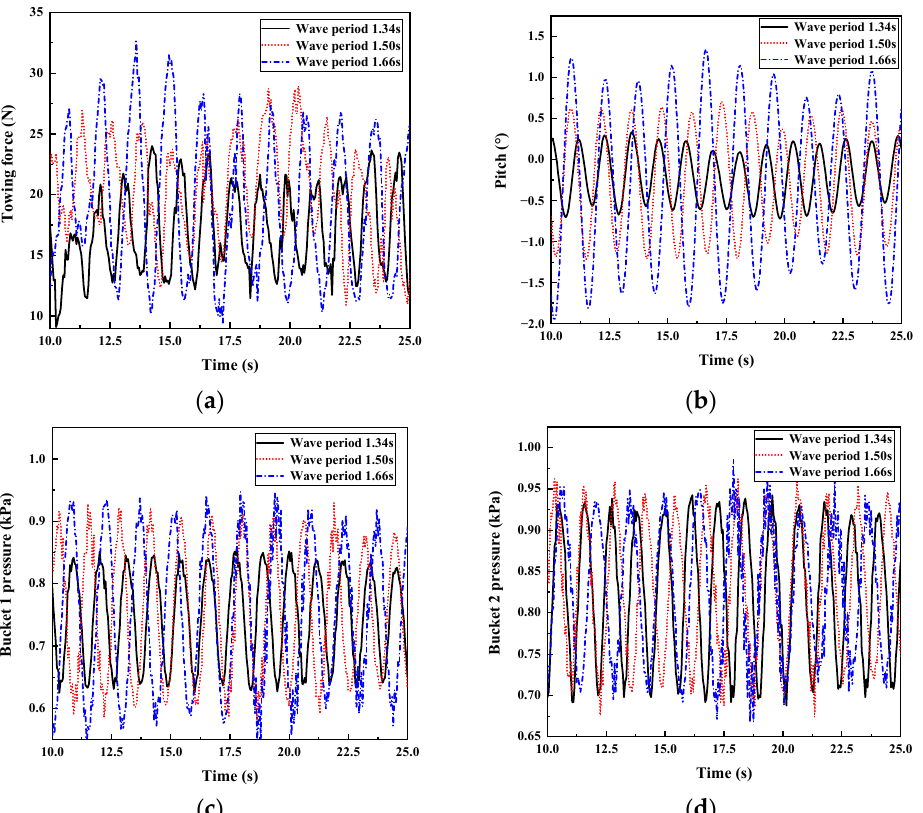
Figure 20. The dynamic response of the TBJF for different wave periods. ( a ) Towing force. ( b ) Pitch. ( c ) Bucket 1 pressure. ( d ) Bucket 2 pressure.